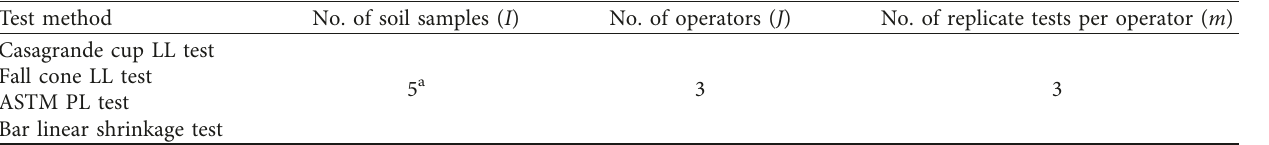
Table 6: Laboratory testing matrix used in this study.